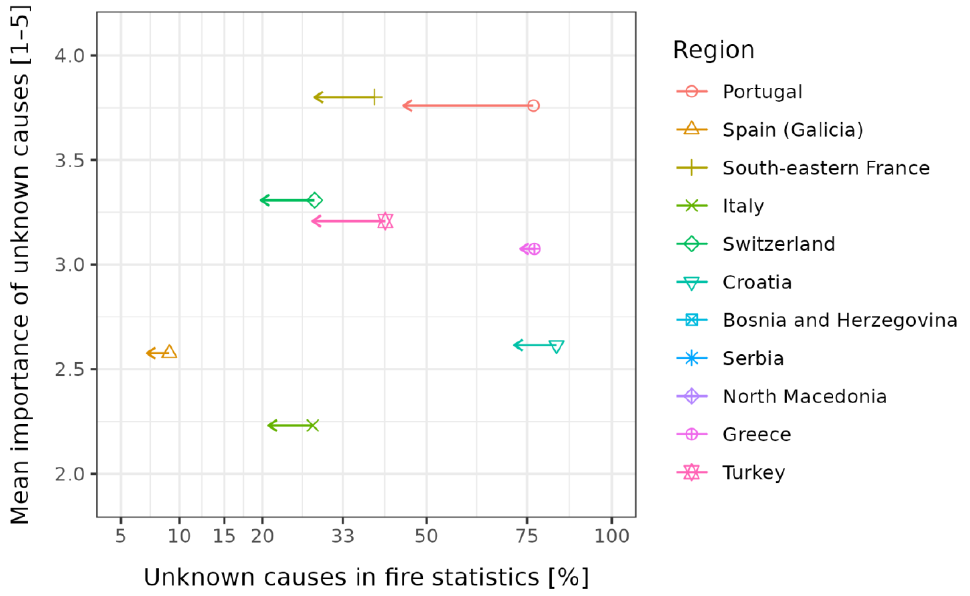
3 Figure 3. Mean expert rating and fire statistics (Dataset B) of Unknown causes. Segments span the difference in the percentages represented by fire frequency (symbols of the regions) and burnt area (arrowheads). The X axis is plotted on a square root-transformed scale. Data were not available for Bosnia and Herzegovina, the Republic of North Macedonia, and